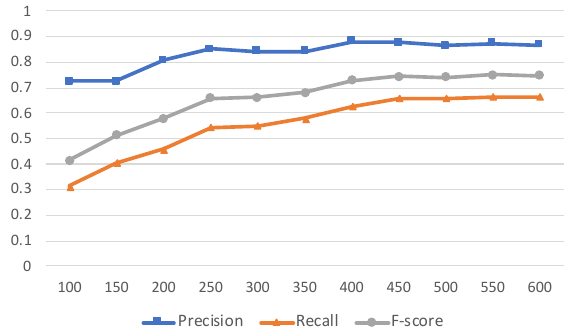
Figure 11. Average recommendation accuracy from varying epochs value with five projects.